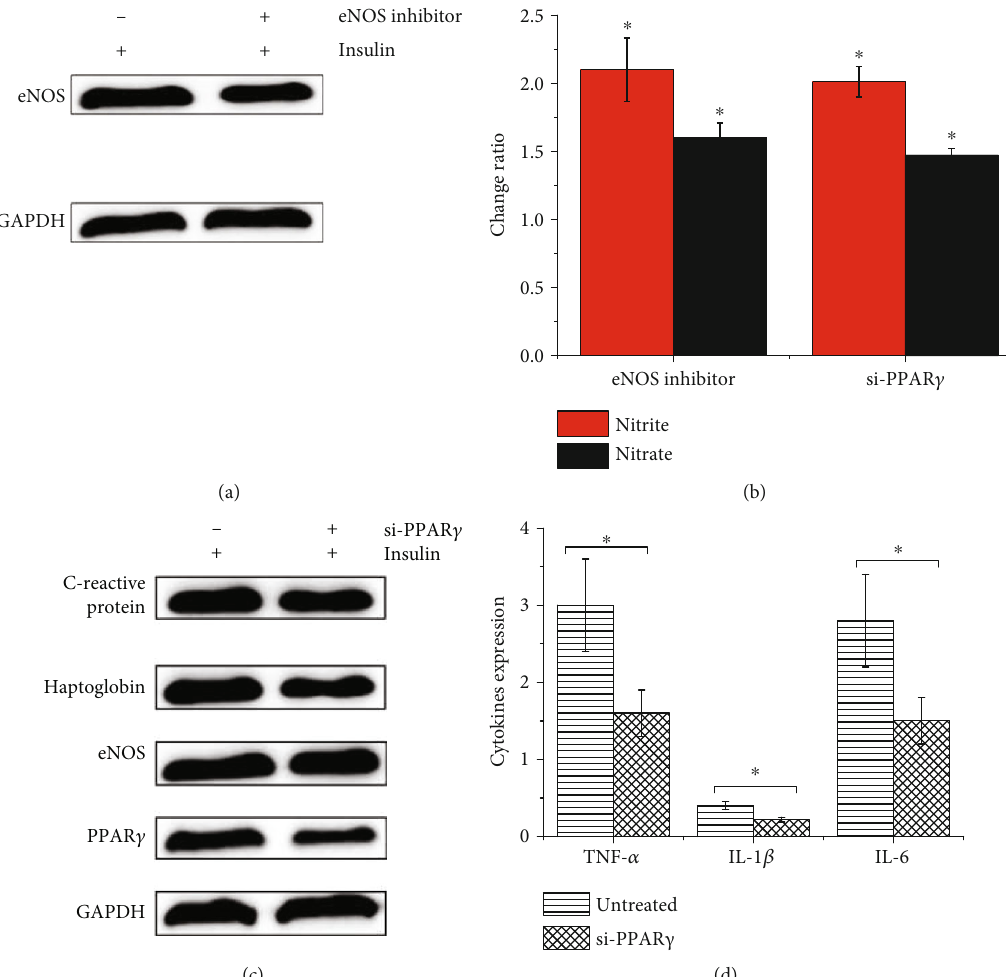
Figure 3: The eNOS, NO, PPAR γ , in fl ammatory factors levels in HepG2 cells. (a) The expression of eNOS in insulin-induced HepG2 cells. (b) The change of nitrite and nitrate in insulin-induced HepG2 cells treated with eNOS inhibitor or si-PPAR γ . (c) The e ff ect of PPAR γ inhibition on the expression of eNOS, PPAR γ , C-reactive protein, and heptoglobin expression in insulin-induced HepG2 cells. (d) The IL- 1 β , TNF- α , and IL-6 levels in insulin-induced HepG2 cells and insulin-induced HepG2 cells transfected with si-PPAR γ